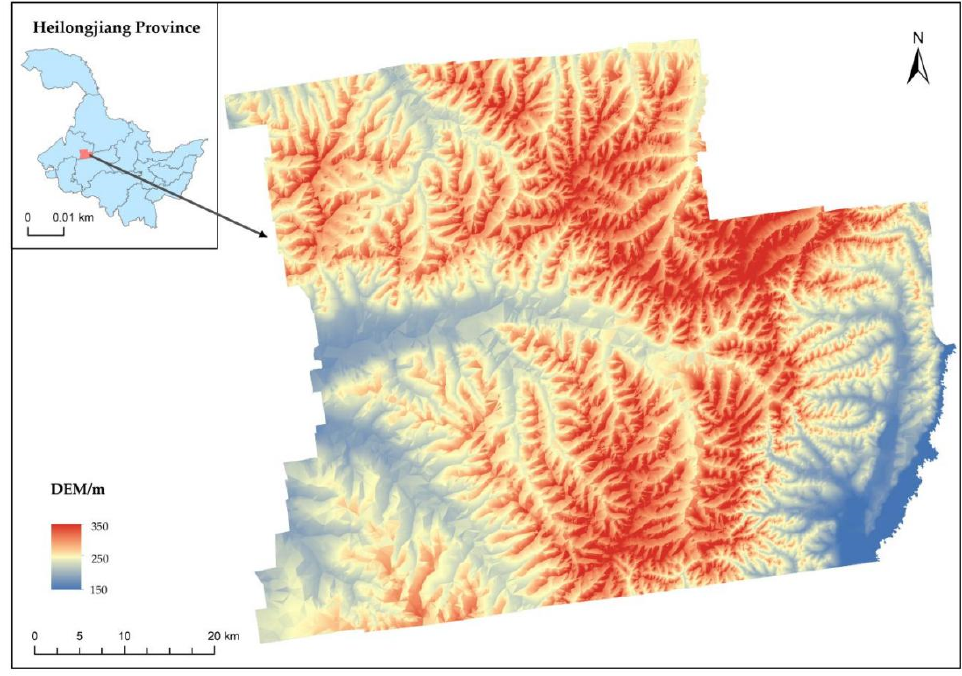
Figure 1. Location and topography of the study area. Table 1. Soil conditions of the study area.